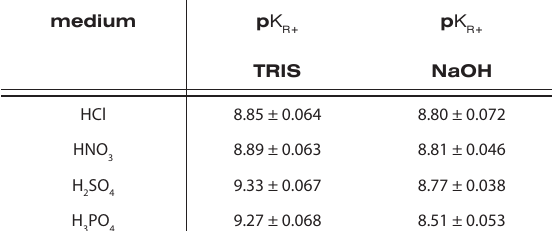
= 6.5 µmol L -1 CHE